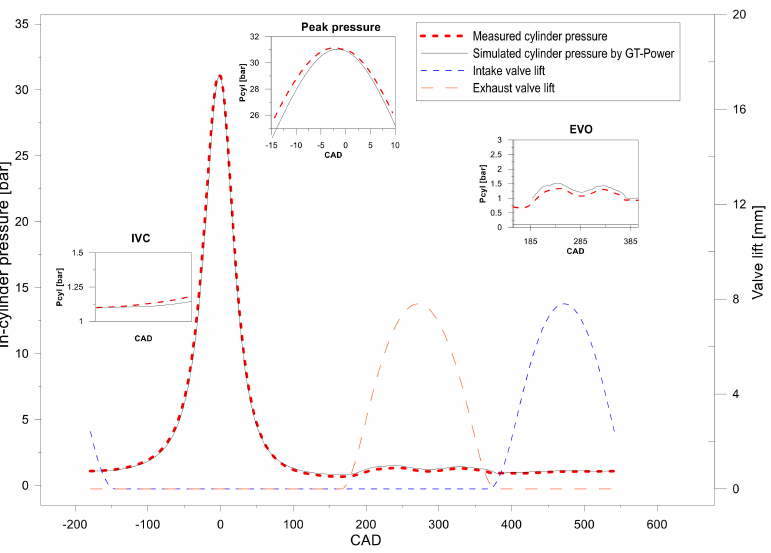
Figure 11. GT-Power simulation versus the measured cylinder pressure.